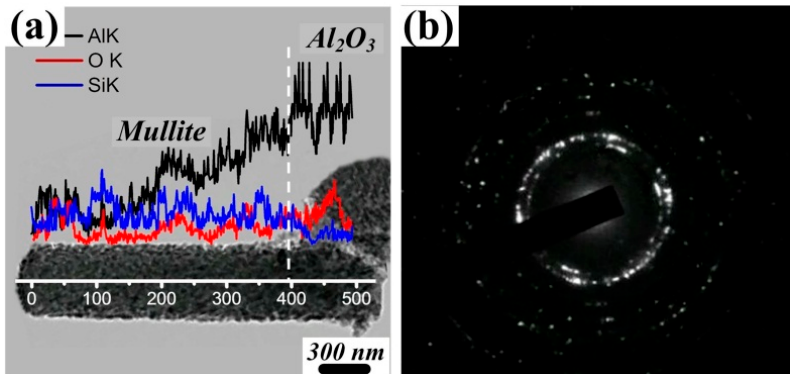
Figure 6. ( a ) Transmission electron microscopy (TEM) morphology of mullite whiskers; ( b ) Diffraction pattern of whiskers.